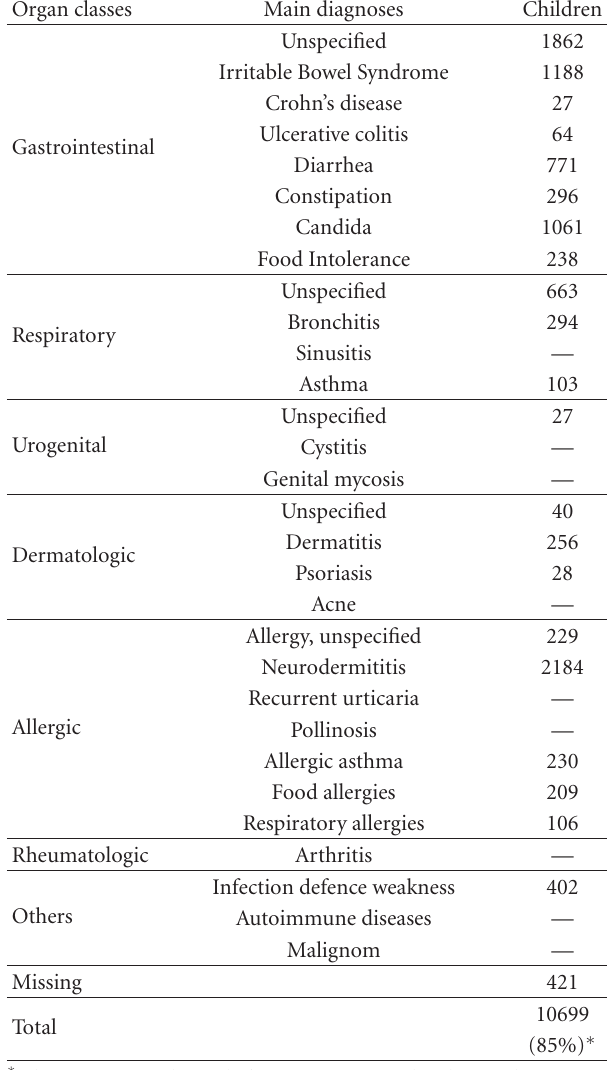
Table 1: Major diagnoses in children that initiated the stool analysis.